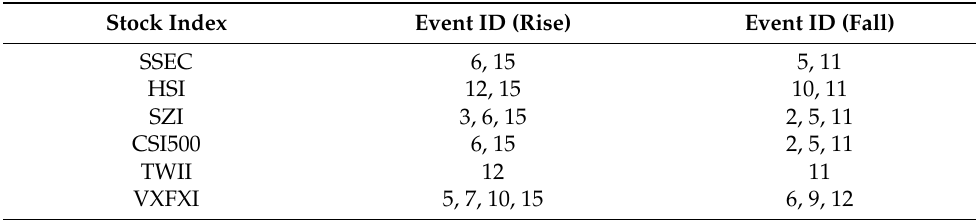
Table 3. Stock market index and its related major